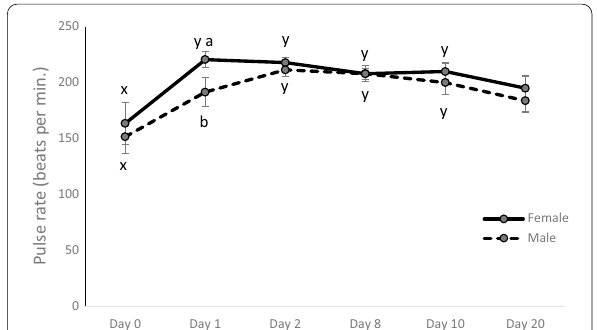
Fig. 9 Changes in morning pulse rate of neonatal buck-kids and doelings from birth to Day 20. Values with a , b and x , y indicate significant different ( P < 0.05) between different sexes and ages,